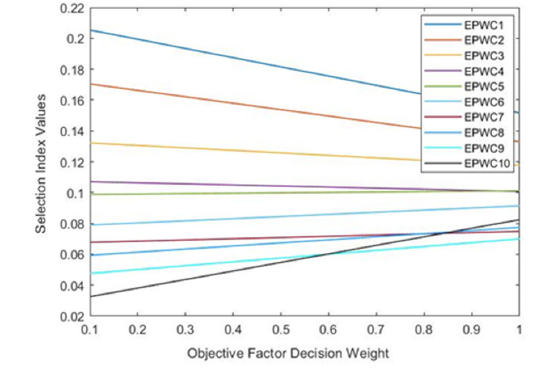
Fig. 4. ENTROPY-COPRAS-based sensitivity analysis Fig. 5. ENTROPY-EDAS-based sensitivity analysis graph